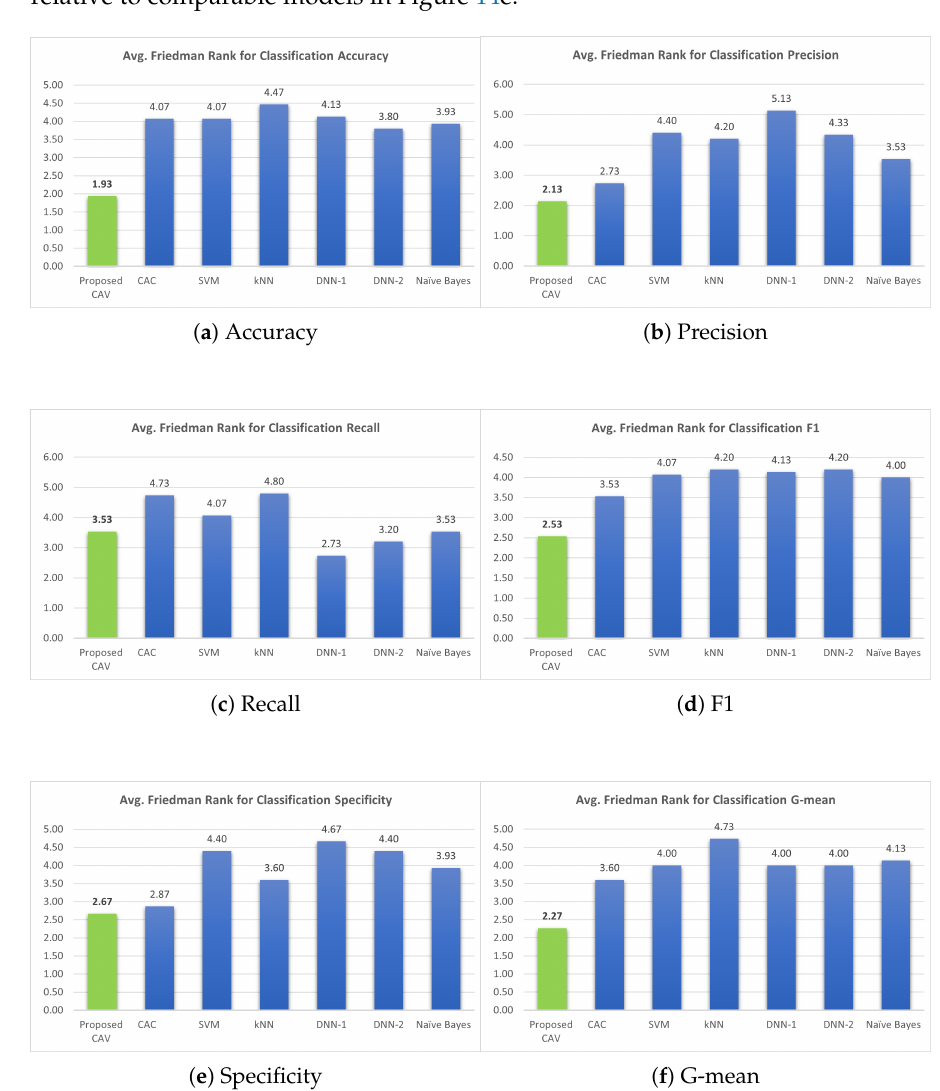
Figure 14. Illustration of the average Friedman rank for CAV, CAC, SVM, kNN, DNN-1, DNN-2, and Naïve Bayes. The green bar graph represents the value of the average Friedman rank in the proposed model, while the blue bar graph represents the corresponding value of the classifier used for comparison with the proposed